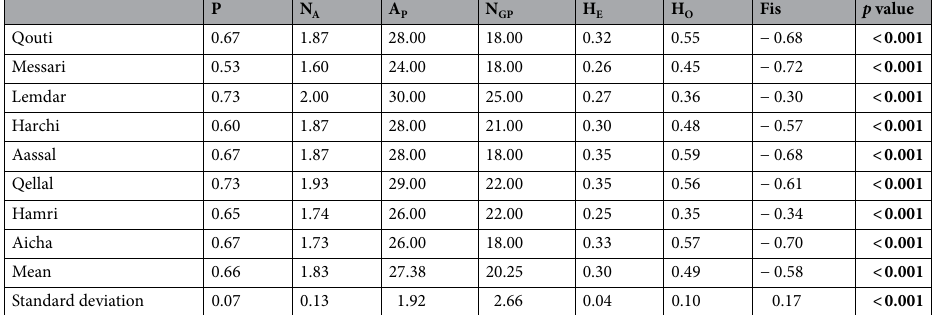
Table 2. Genetic diversity for the eight varieties of Ficus carica based on 15 microsatellite markers. Polymorphism information content ( P ), average number of alleles per locus ( NA ), allelic richness ( A P ), range size of alleles by variety, number of genotype ( N GP ), expected heterozygosity ( H E ), observed heterozygosity ( H 0 ) and Wright’s fixation indices ( Fis ) are presented. Significant p values ( p < 0.05) are indicated in bold.